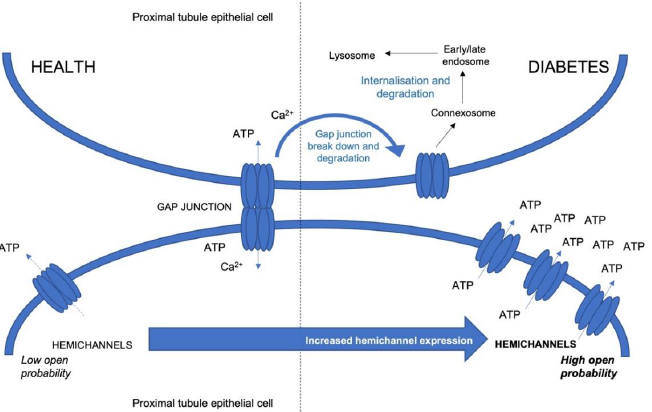
Figure 1. A schematic highlighting changes in hemichannel activity in health and diabetes. During injury, gap junctions break apart. These broken channels undergo endocytosis, assemble into a double membrane structure termed a connexosome and then experience endosome sorting prior to transportation to lysosomes for degradation [53]. These events are paralleled by an upregulation of hemichannel activity and number, leading to an increase in release of molecules, including ATP, causing downstream inflammation and fibrosis via purinergic signalling. 2. Targeting Inflammation in Microvascular Complications of Diabetes Instrumental to the pathogenesis of diabetes and its complications, targeted anti-in- flammatory therapy has been suggested for both prevention and treatment of diabetes and has been extensively reviewed [54 – 56]. Known to underpin disease progression across multiple age associated conditions e.g., diabetes [55], obesity [25] and age-related macular degeneration [57], recent attention has focussed on the design of pharmacological compounds that block key inflammatory candidates, such as the nod-like receptor protein